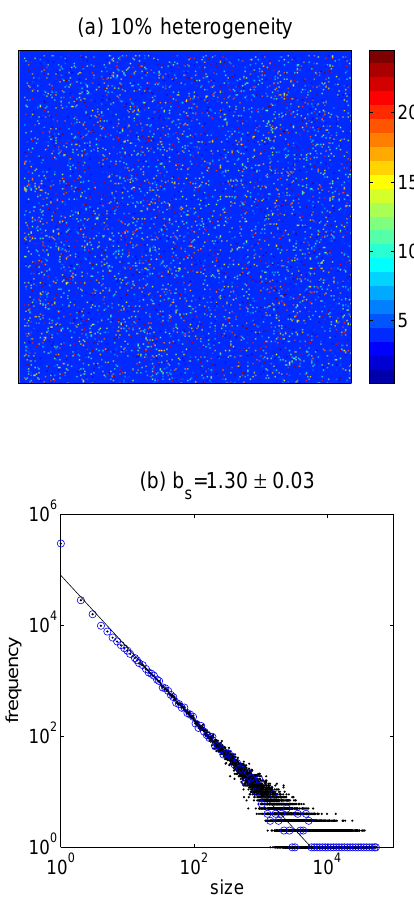
Figure 1. (a) Example of a case of diversified heterogeneity with toppling thresholds randomly sampled in the range of the value 2 to 24 (color bar); the heterogeneity covers 10% of the area of the 2- D model lattice with 256 × 256 cells, and it is embedded in a back- ground field of threshold 4 (medium blue), which occupies the re- maining 90% of the lattice area. (b) The power law frequency–size distribution yields an scaling exponent of b s = 1.30 ± 0.03 (denoted along with the standard error). Note that the inevitable scattering across the large size events (marked by black dots) is considerably simplified by regrouping the sizes into bins of 1.1 i –1.1 i + 1 size in- terval (blue circles; see the